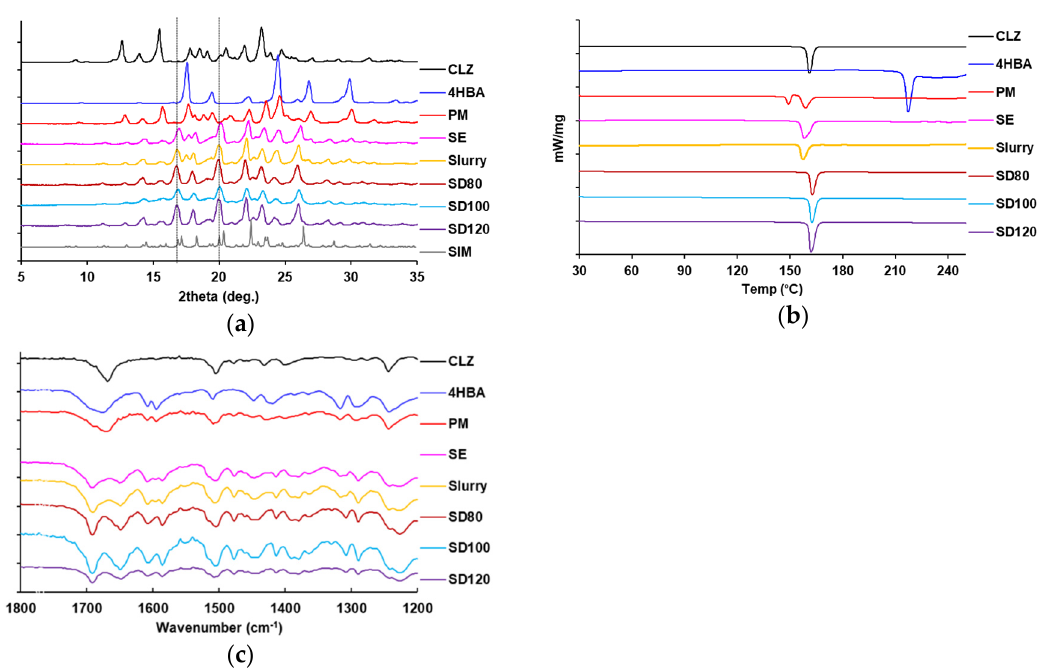
Figure 3. ( a ) PXRD, ( b ) DSC, and ( c ) FT-IR analysis of the CLZ-4HBA cocrystals prepared using the solvent evaporation method, slurry method, or spray drying method at 80, 100, and 120 ◦